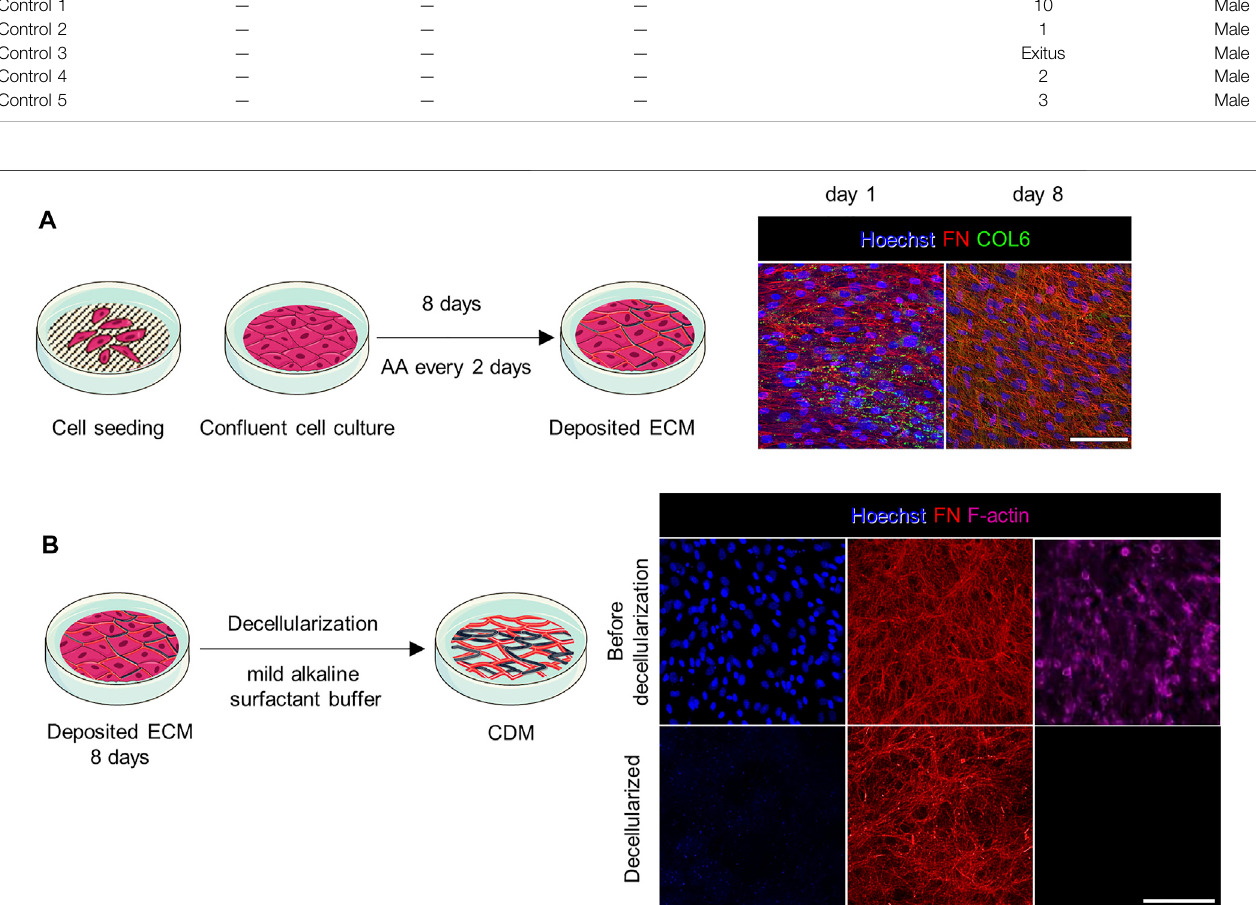
FIGURE 1 | Preparation and application of CDMs. (A) Con fl uent cultures of fi broblasts were stimulated with AA for 8 days to promote the secretion of a dense fi brillar ECMrichincollagen.Ontheright,representative confocalimagesshow cellstainingat day1and8ofculture(prior decellularization).Cellnucleiwerestainedwith Hoechst. The complexity and interconnection of secreted fi brils increased over time. (B) The ECM was evaluated by immunostaining before and after decellularization. After decellularization no cellular structures such as cell nuclei (stained with Hoechst) and cytoskeleton (F-actin) were observed. Scale bars: 100 µm.